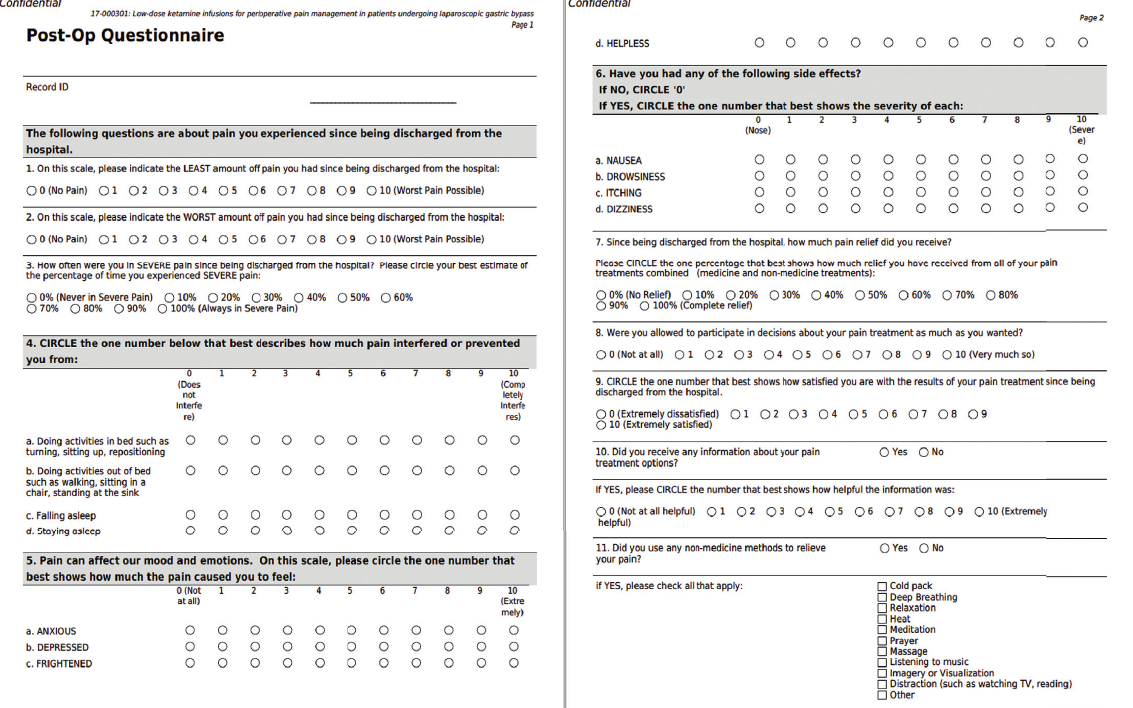
Figure 3: The postop questionnaire/survey given to patients at their first postop follow-up appointment since being discharged from the